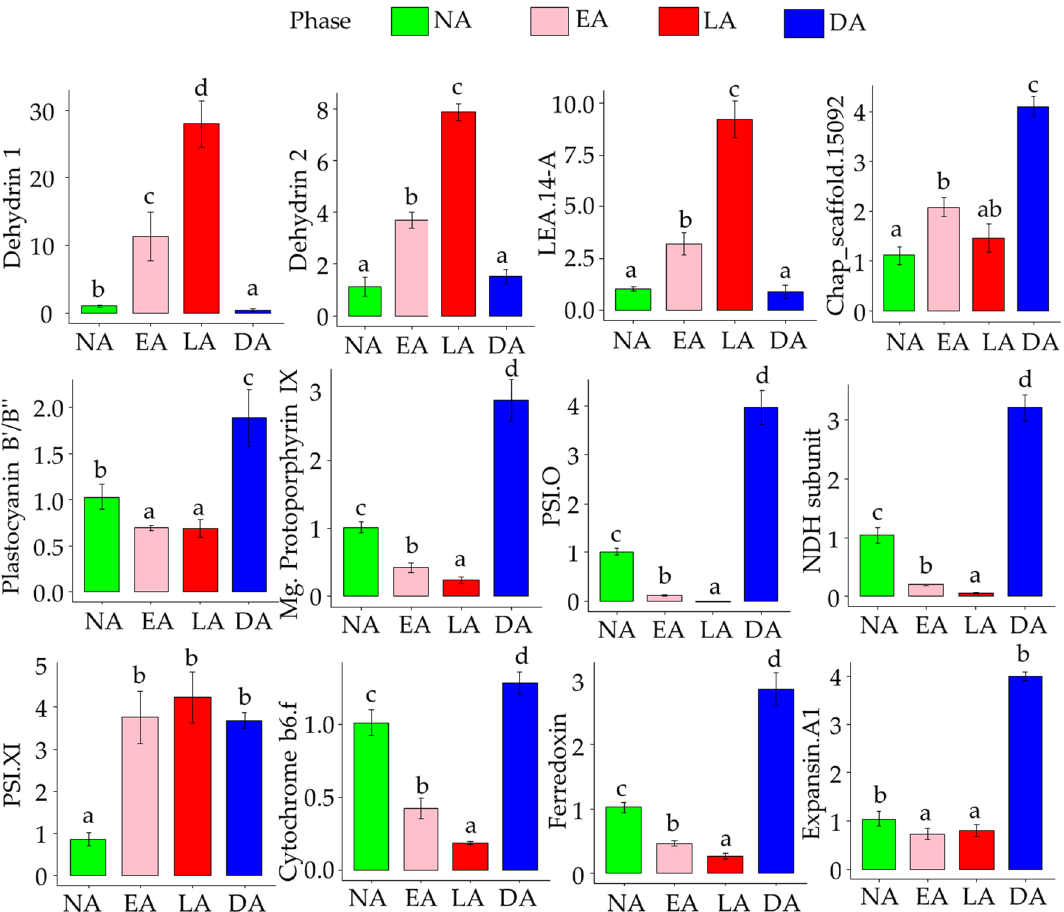
Figure 5. Validation of genes using RT-qPCR. Different alphabets (a, b, c, d) represent statistically significant values ( p ≤ 0.05) as determined by Tukey’s post-hoc test. LEA.14A = Late Embryogenesis Abundant, Chap_scaffold.15092 = BAG family molecular chaperone regulator 7, Mg.Protoporphyrin IX = Magnesium- protoporphyrin IX monomethyl ester [oxidative] cyclase, PSI.XI = Photosystem I subunit XI and PSI.O = Photosystem I subunit